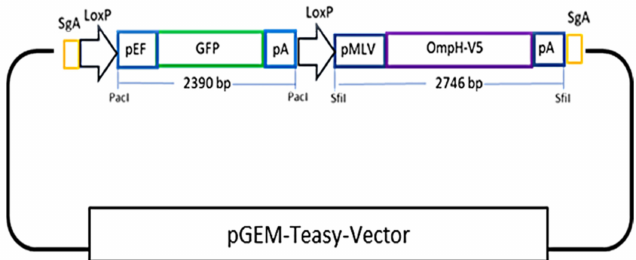
Figure 1. A schematic representation of the cloning strategy for donor plasmid construction contain- ing the OmpH-V5 expression cassette tagged with a removable GFP reporter cassette. Table 2. Primer sequences used for sgRNA plasmid and donor plasmid construction. Primer